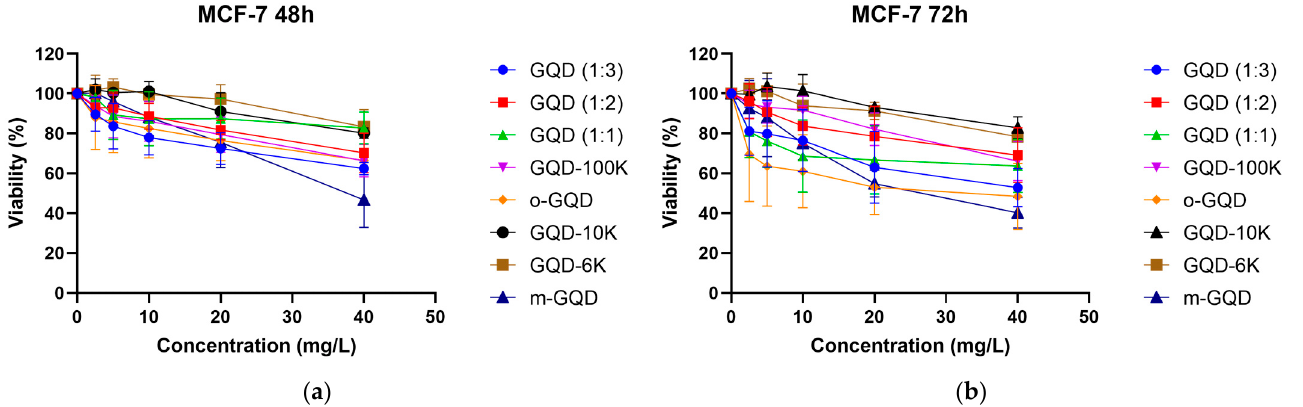
Figure 1. Changes in cell viability of MCF-7 cells treated with different doses of eight GQDs for ( a ) 48 h and ( b ) 72 h. The control group comprises cells without GQDs treatment (0 mg/L). The data indicate averages from triplicates, and the error bars indicate standard deviation (SD). Significance is determined by using two-way ANOVA statistical analysis.